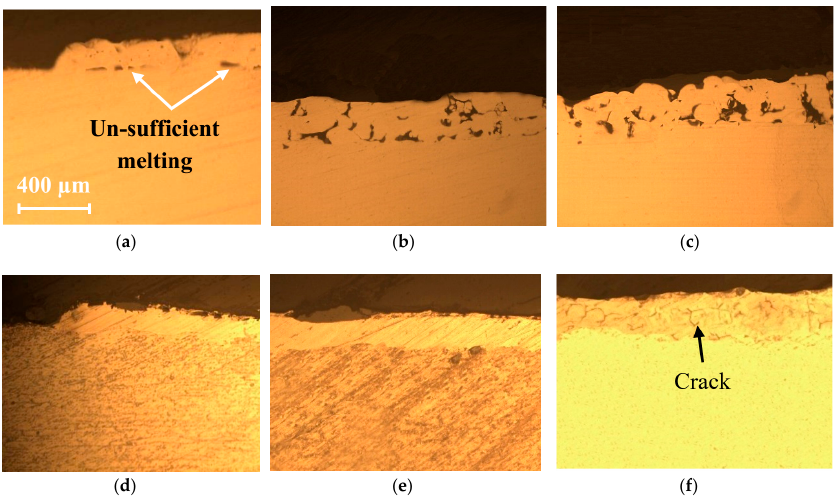
Figure 7. Optical micrographs showing the multi-line formation test results. Al 2 O 3 -reinforced samples of: ( a ) 3 wt%., ( b ) 5 wt%., and ( c ) 7 wt%. Al 2 O 3 -ZrO 2 reinforced samples of: ( d ) 3 wt%., ( e ) 5 wt%., and ( f ) 7 wt%.